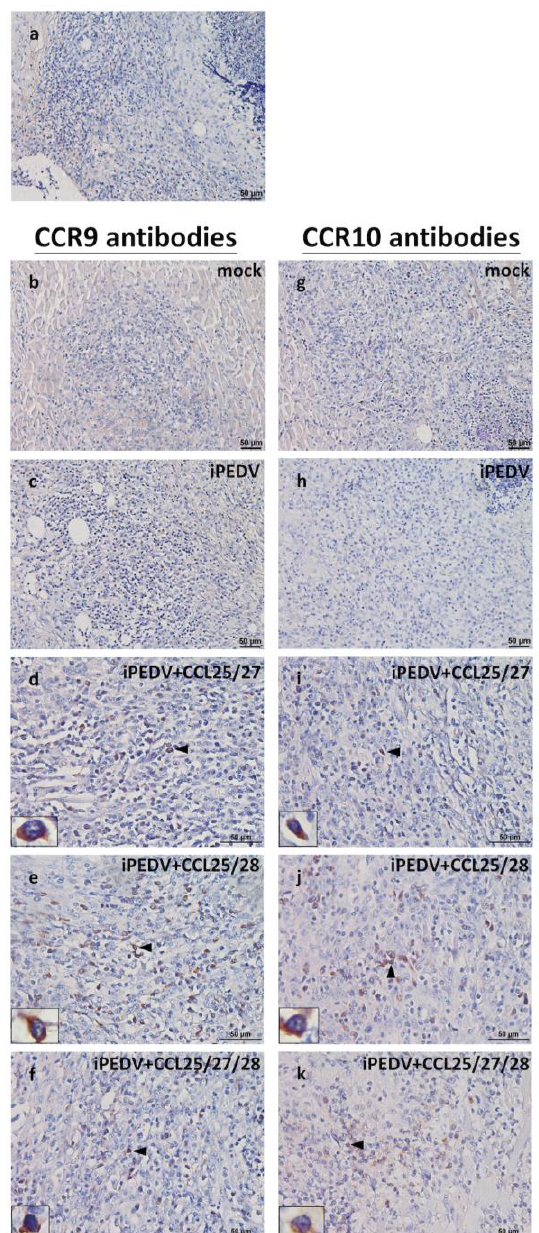
Figure 8. Detection of the expression of CCR9 and CCR10 antigens in injection-site inflammatory cells by immunohistochemistry (IHC). Those infiltrating inflammatory cells were incubated with an anti-CCR9 and CCR10 antibodies (1:250 and 1:200 dilution) as the primary antibody, conjugated with the EnVision-HRP system (rabbit / mouse) as the secondary antibody, and then visualized by the EnVision-DAB + system by a light microscopy. ( a ) The tissue section stained synchronously without applying the primary antibodies was taken as a negative control. ( d , i ) Scattering CCR9 and CCR10 antigens were observed in the cytoplasm of inflammatory cells in the iPEDV + CCL25 / 27, ( e , j ) iPEDV + CCL25 / 28, and ( f , k ) iPEDV + CCL25 / 27 / 28 group. Rare CCR9 and CCR10 positive signals were detected in the mock ( b , g ) and iPEDV ( c , h ) group. Scale bars are 50 μm.